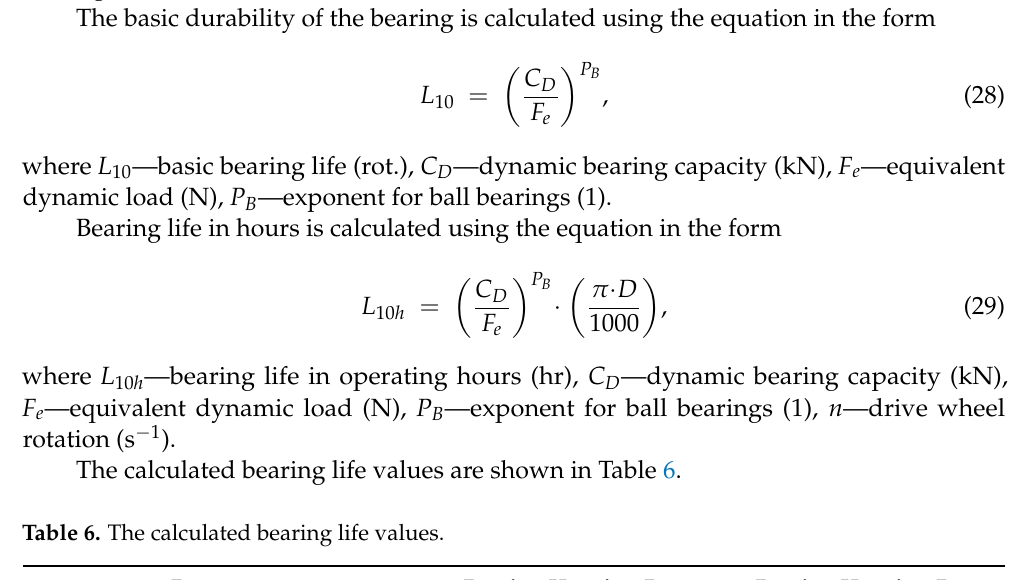
Table 6. The calculated bearing life values. Parameter Bearing Housing R A Bearing Housing R B The equivalent dynamic bearing [N] 220.041 386.659 Basic bearing durability [10 6